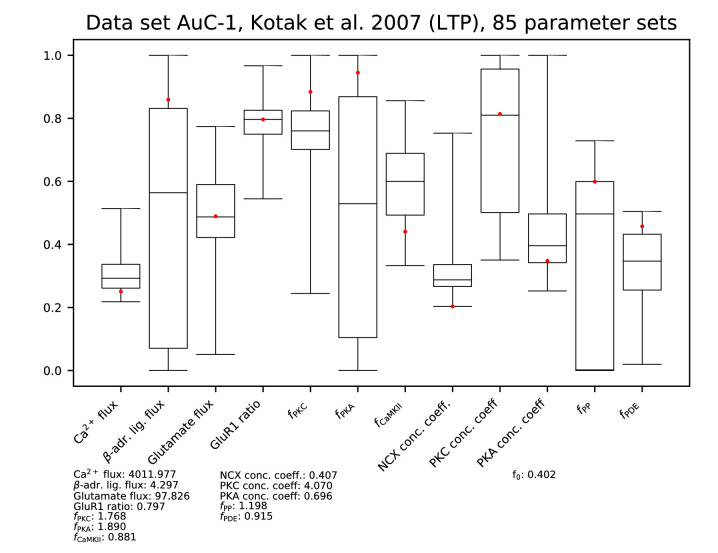
Parameters for data set AC-1.See Figure 9—figure supplement 1 for details.